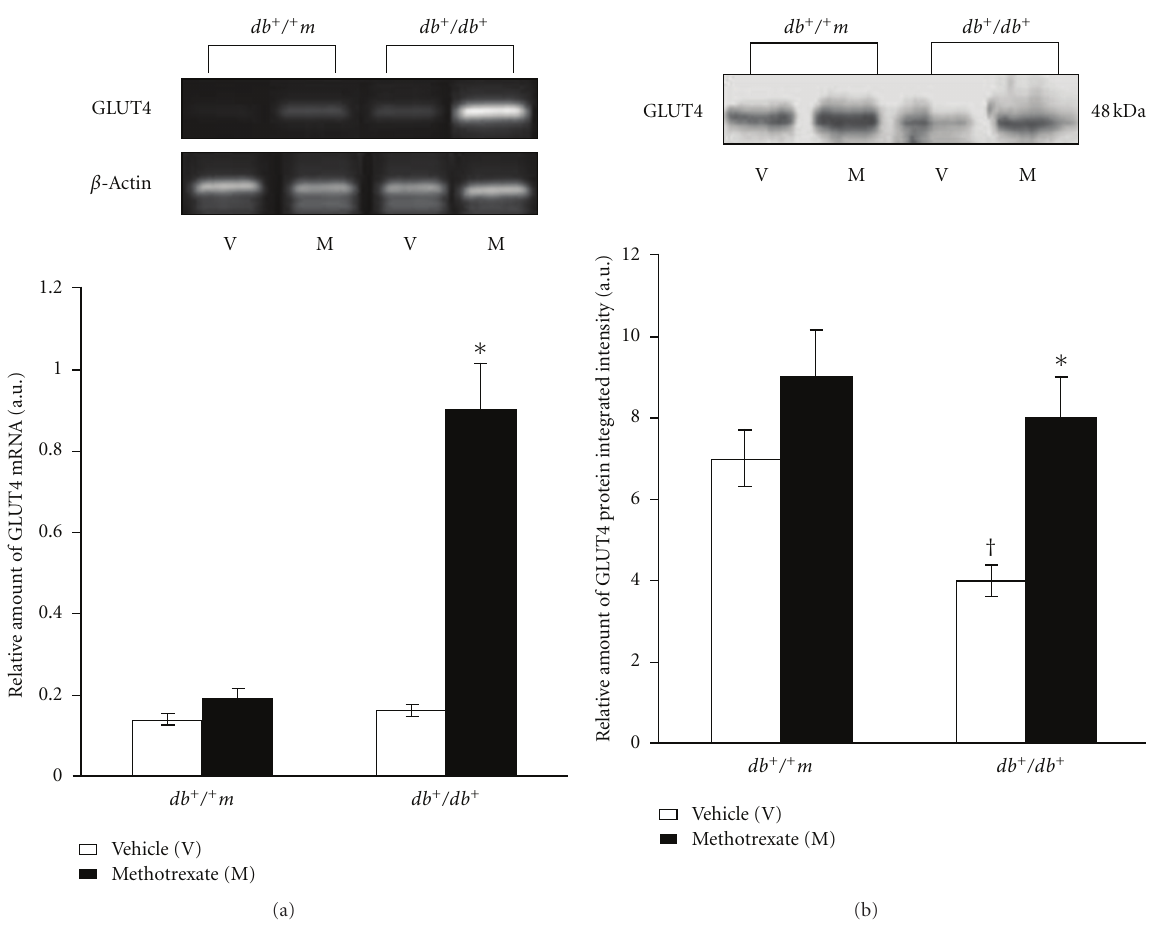
Figure 1: (a)GLUT4 mRNA expression in muscle specimens collected from normoglycemic db + / + m mice and diabetic db + /db + mice treated with either vehicle (white bars) or methotrexate (black bars). The upper panel shows representative gels highlighting GLUT4 mRNA expression. The lower panel shows quantitative data and represents the mean ± SD of seven experiments. ∗ P < 0 . 01 versus db + /db + plus vehicle. (b) Western blot analysis of the GLUT4 protein in muscle specimens from normoglycemic db + / + m mice and diabetic db + /db + mice treated with either vehicle (white bars) or methotrexate (black bars). The upper panel shows representative autoradiography highlighting GLUT4 protein expression. The lower panel shows quantitative data and represents the mean ± SD of seven experiments. ∗ P < 0 . 01 versus db + /db + plus vehicle ; † P < 0 . 05 versus db + / + m plus vehicle.